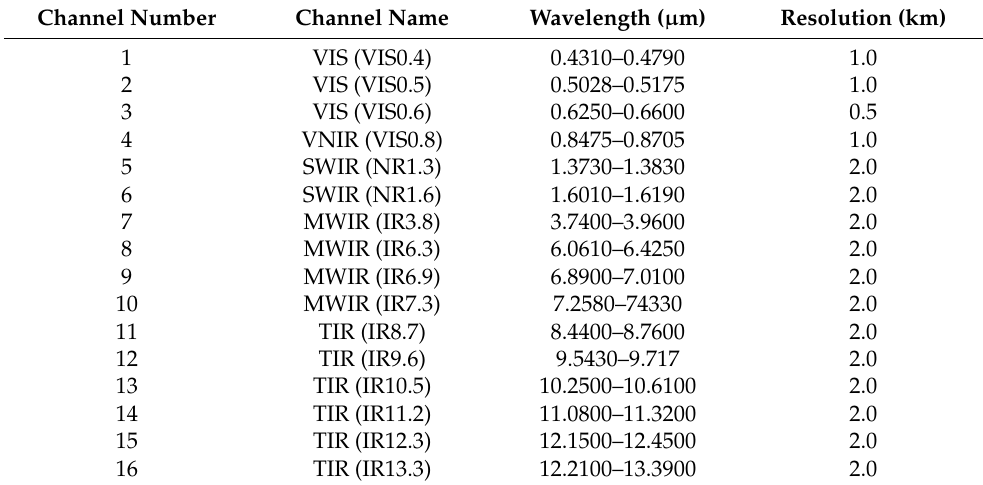
Table 1. Specifications for GEO-KOMPSAT-2A Advanced Meteorological Imager (GK-2A/AMI) spectral